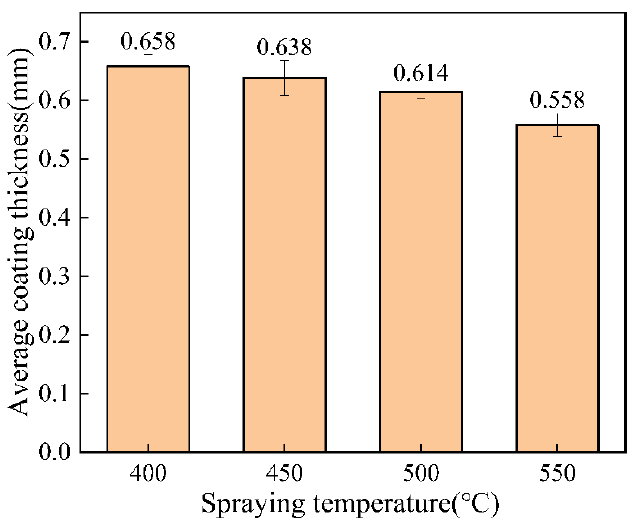
Figure 8. Average coating thickness at different spraying temperatures.